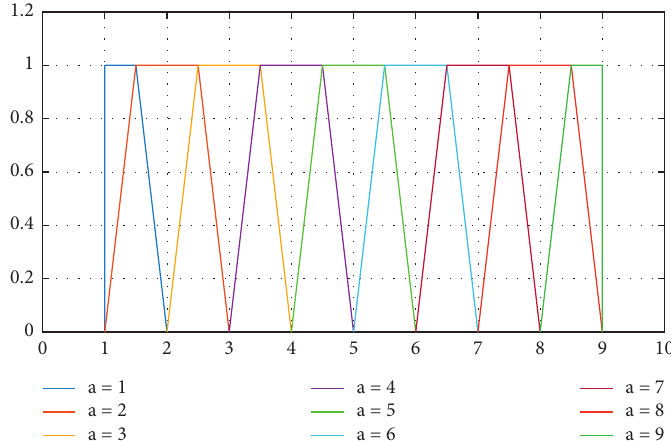
Figure 3: Membership functions of trapezoid fuzzy numbers 􏽥 a ( a � 1–9).